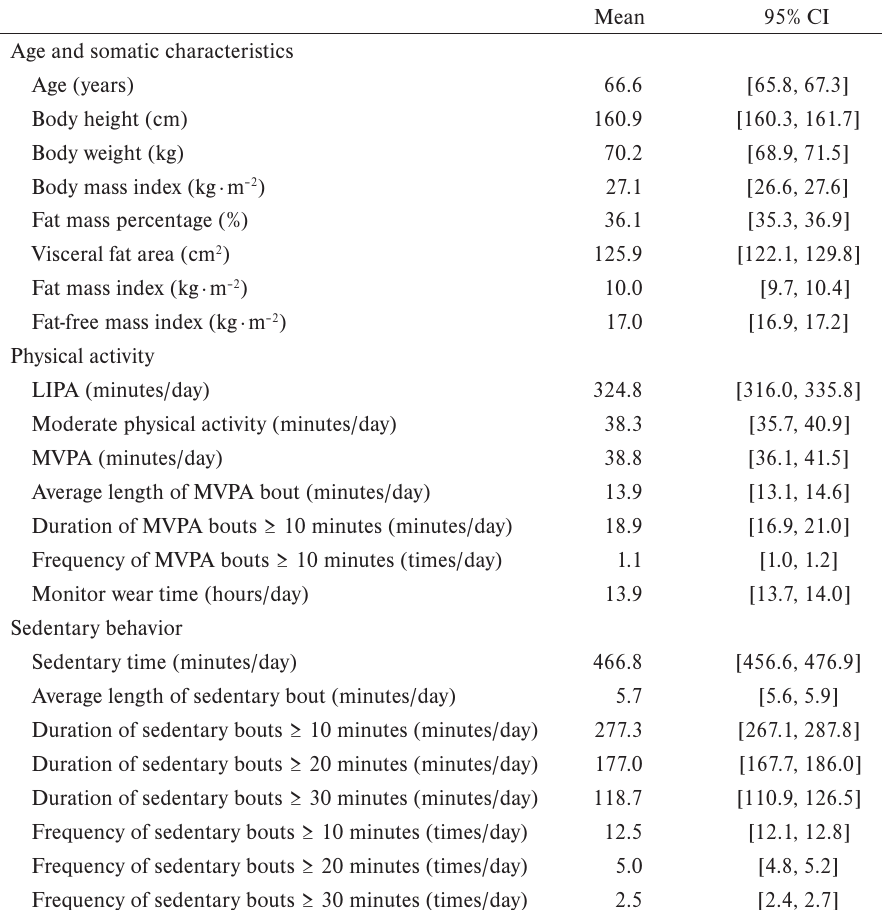
Descriptive characteristics of sample (N =